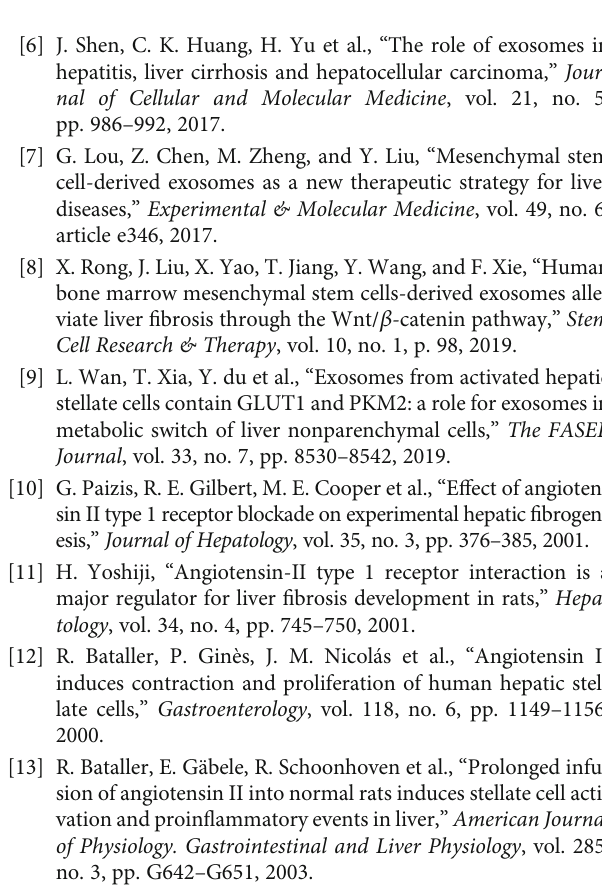
Figure 11: Schematic presentation of this study. An ERS response was evoked by ASK1 activation, which caused Ang II-induced HSCs to release exosomes. The exosomes released by activated HSCs were taken up by quiescent HSCs, which were then activated by the